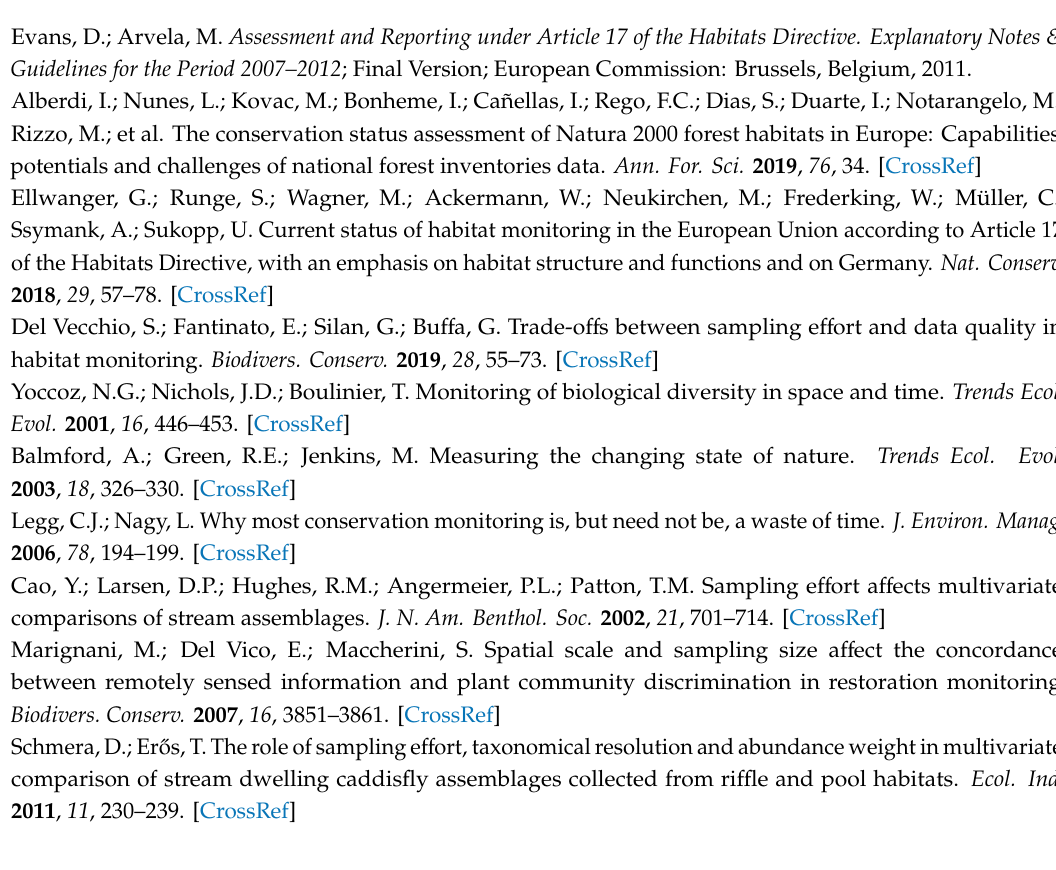
Figure S1: Profile of pseudo multivariate dissimilarity-based standard error (MultSE) based on Jaccard dissimilarity for each EUNIS habitat type within the three sampling areas. PU = Parco dell’Uccellina, SP = SelvaPisana, TL = Torre del Lago, Figure S2: SIMPER output derived from 999 random resampling of the original community based on plot numbers given by decay of MultSE. Bar plots represent the proportion of resampling for each species, red dashed lines indicate an 80% contribution, Table S1: Results of PERMANOVA pairwise test for the interaction SAC × habitat. PU—Parco dell’Uccellina—TL—Torre del Lago—SP—Selva Pisana; B1.3—shifting coastal dunes, B1.4—stable dune grassland—B1.6—coastal dune scrub”, Table S2: “SIMPER output reporting species contribution to average between-group dissimilarity (Average), the corresponding standard deviation (SD), average abundances per group (Av.a, Av.b), and the cumulative contribution of the species (Cum. Contr.). NB. only species contributing up to 50% are